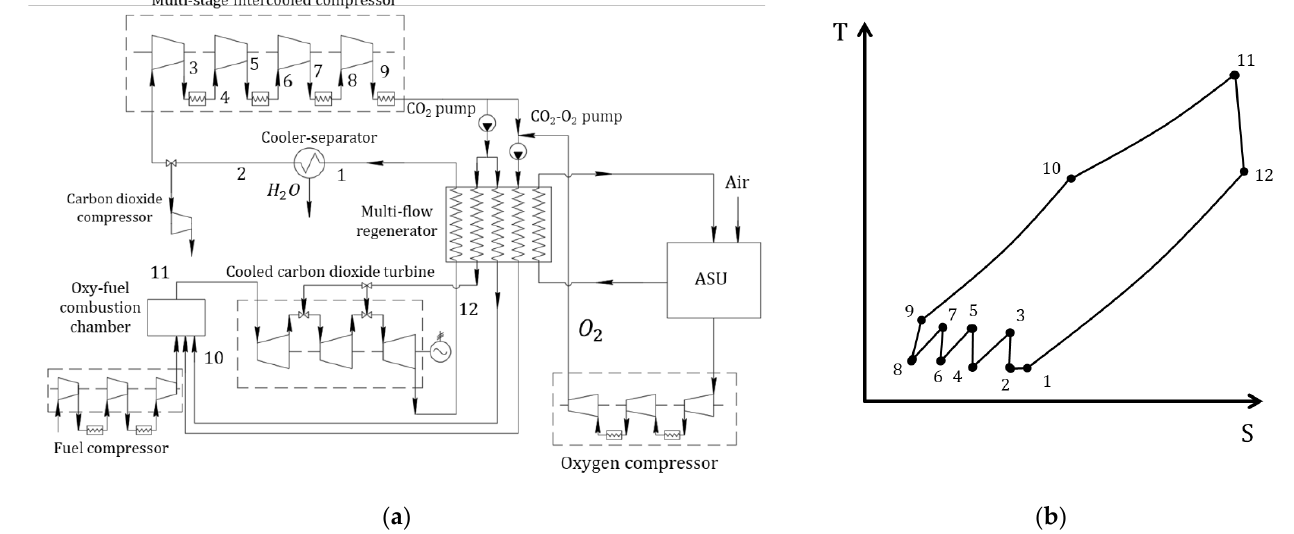
Figure 20. Allam cycle: ( a ) schematic diagram; ( b ) T – S diagram [35]. ASU — air separation unit.